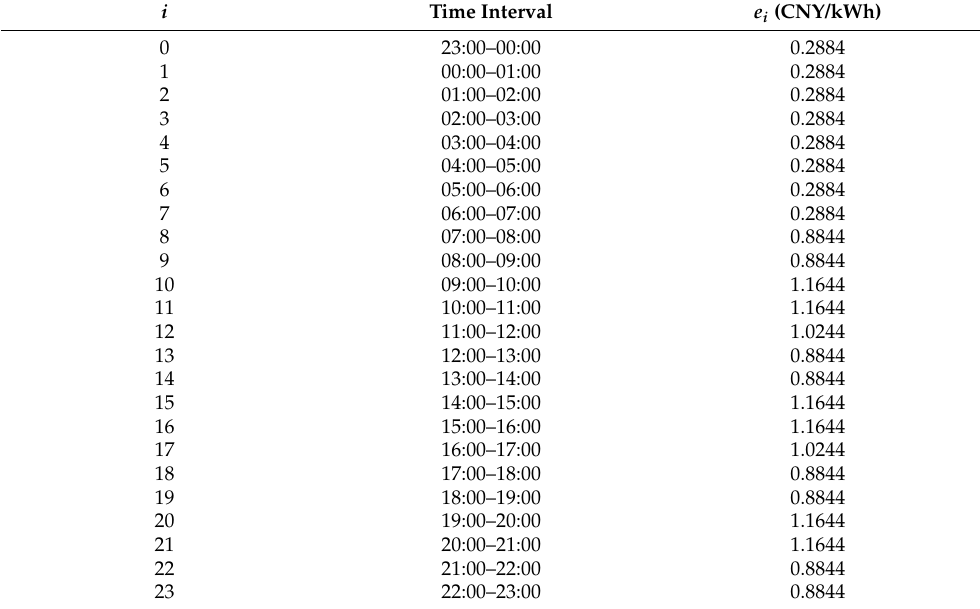
Table A1. Electricity tariffs ( e i ) at different time intervals of the